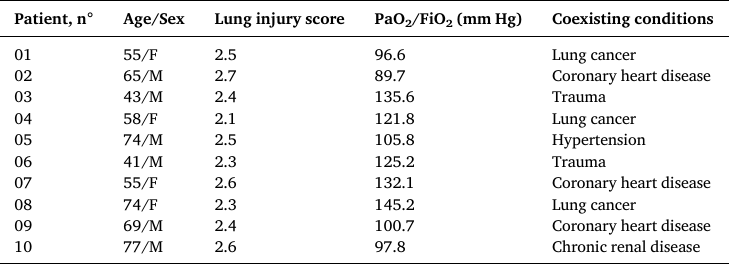
Table 1 Clinical characteristics of ARDS patients.